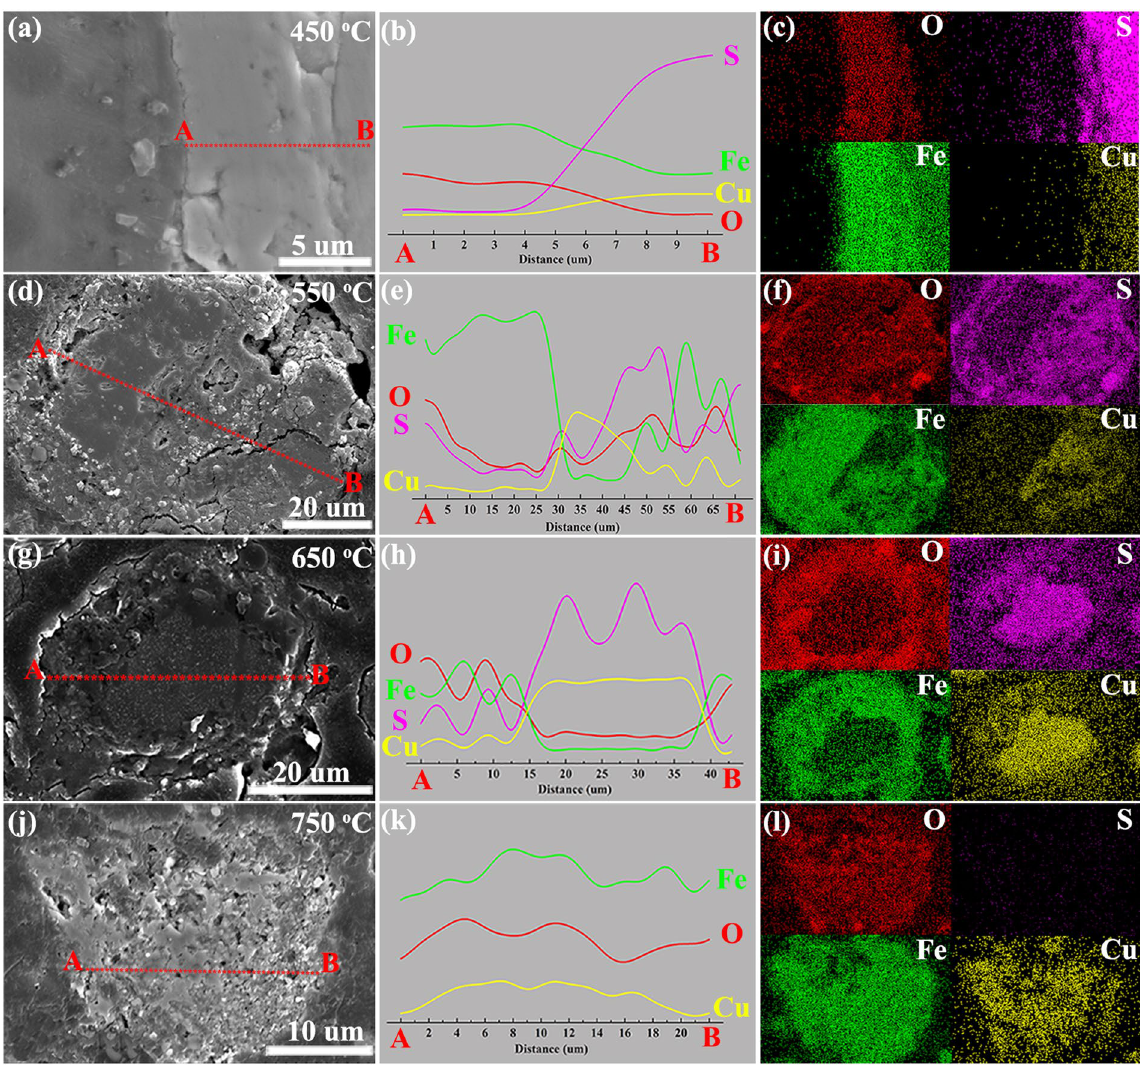
Figure 6. SEM, EDS–line–scanning, and EDS–mapping results for elements (O, S, Fe, and Cu) over the cross section of Ccp particles after the roasting at 450 °C ( a – c ), 550 °C ( d – f ), 650 °C ( g – i ), and 750 °C ( j – l ) in